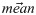
Hypoxia gradient analysis.Intensity level analysis produced by the Intensity-Sample-Ray-Bundles algorithm for centers 1 (left 3 panels), 2 (middle 3 panels), and 3 (right 3 panels). Intensity-Sample-Ray-Bundles creates three plots of the data, where the horizontal axis denotes distance from the center (pixels), and the vertical axis denotes intensity level. The first panel shows every ray measurement (light gray), upon which mean→ (blue) and median→ (red) are overlaid; its title gives rm (pixels). The second panel shows mean→ (blue) ± std→ (gray), overlaid with segmented least squares fits to mean→ (black); its title gives the length (l, pixels), slope (s), and least squares error (e, pixels) for each fitted segment. The third panel shows median→ (red) ± std→ (gray), overlaid with segmented least squares fits to median→ (black); its title gives the length (l, pixels), slope (s), and least squares error (e, pixels) for each fitted segment. The segmented least square fits are given by a dynamic programming algorithm using a cost parameter C = 200.